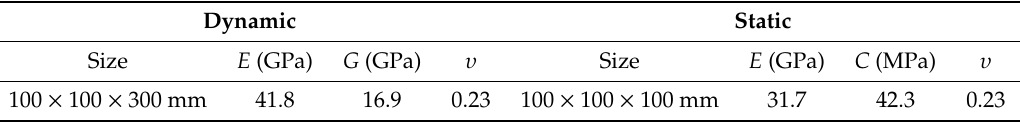
Table 4. Dynamic and static mechanical parameters.